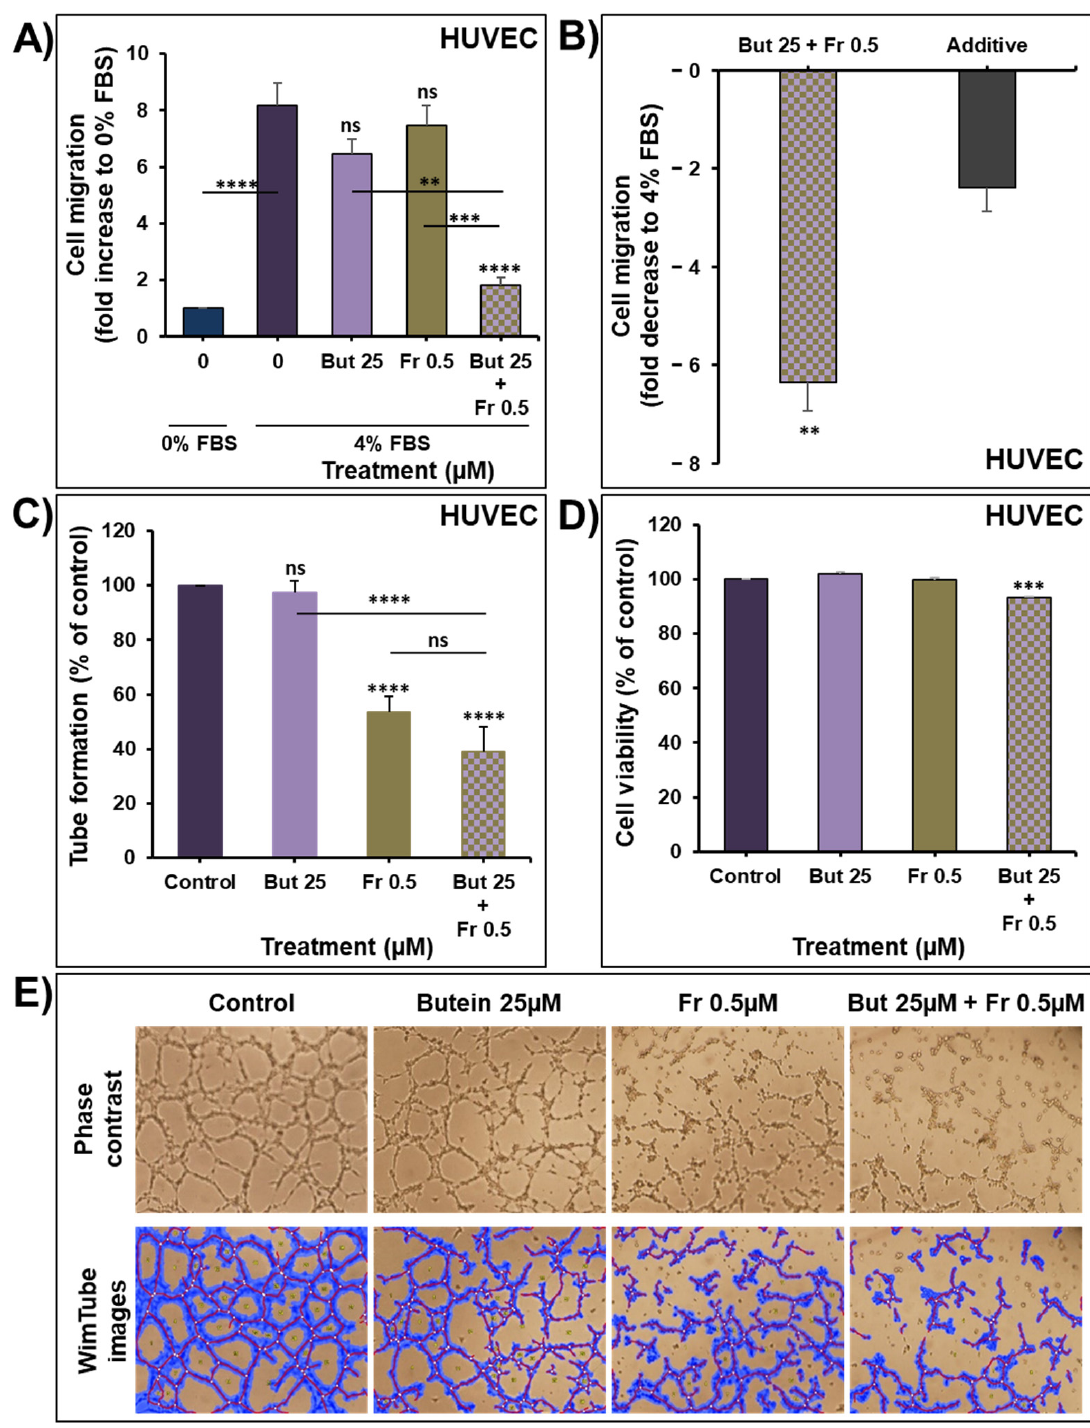
Figure 8. Effect of butein (25 µM) in combination with frondoside-A (0.5 µM) on HUVECs migration after 8 h of treatment ( A ). Effect of the combination on HUVECs migration compared with the calculated additive effects of the two drugs alone ( B ). Data were expressed as fold induction compared to the control group. ( C – E ) Impact of butein and frondoside-A alone and in combination on HUVECs capillary-like-structure formation and cell viability after 8 h of treatment. The statistical significance is compared to the control (4% FBS) except for the specified lines. All experiments were repeated at least three times. Columns are means; bars are S.E.M. ** Significantly different at p < 0.01, *** Significantly different at p < 0.001, **** Significantly different at p < 0.0001. ns—non-significant.